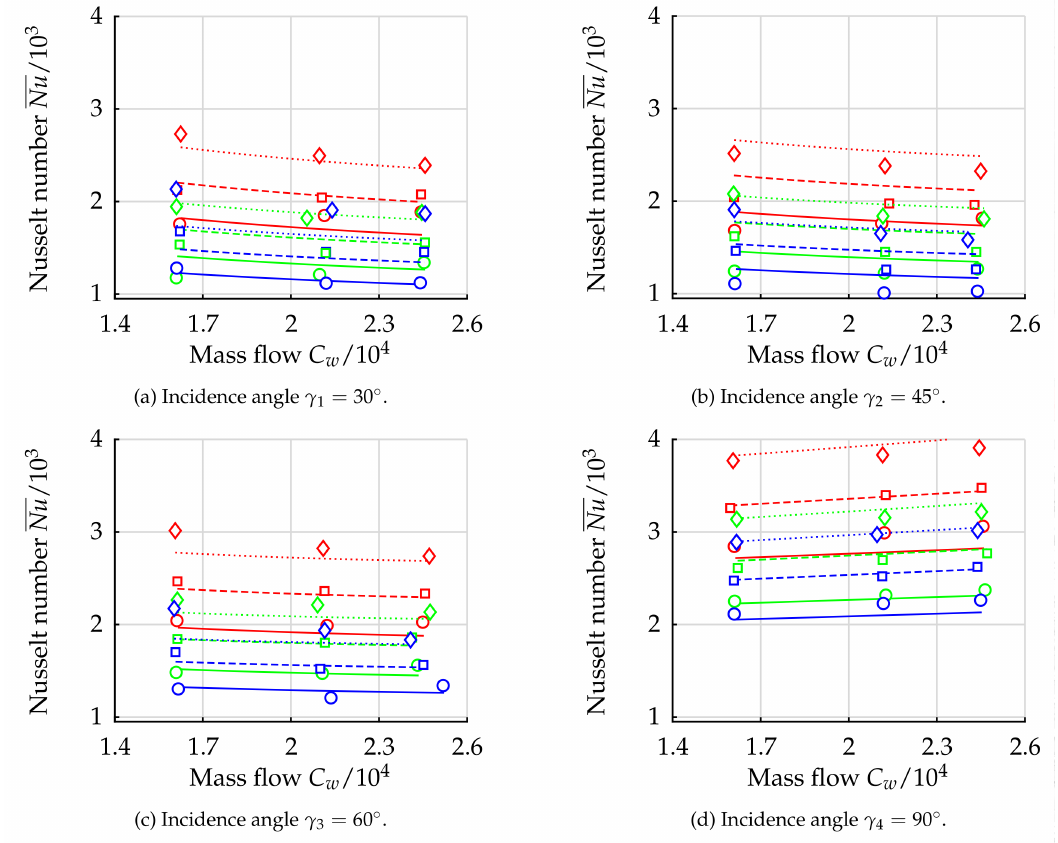
Figure 10. Comparison between measured data (symbols) and the derived correlation (lines) as a function of the mass flow rate C w for each incidence angle γ and the varations: Re ϕ 1 : G 1